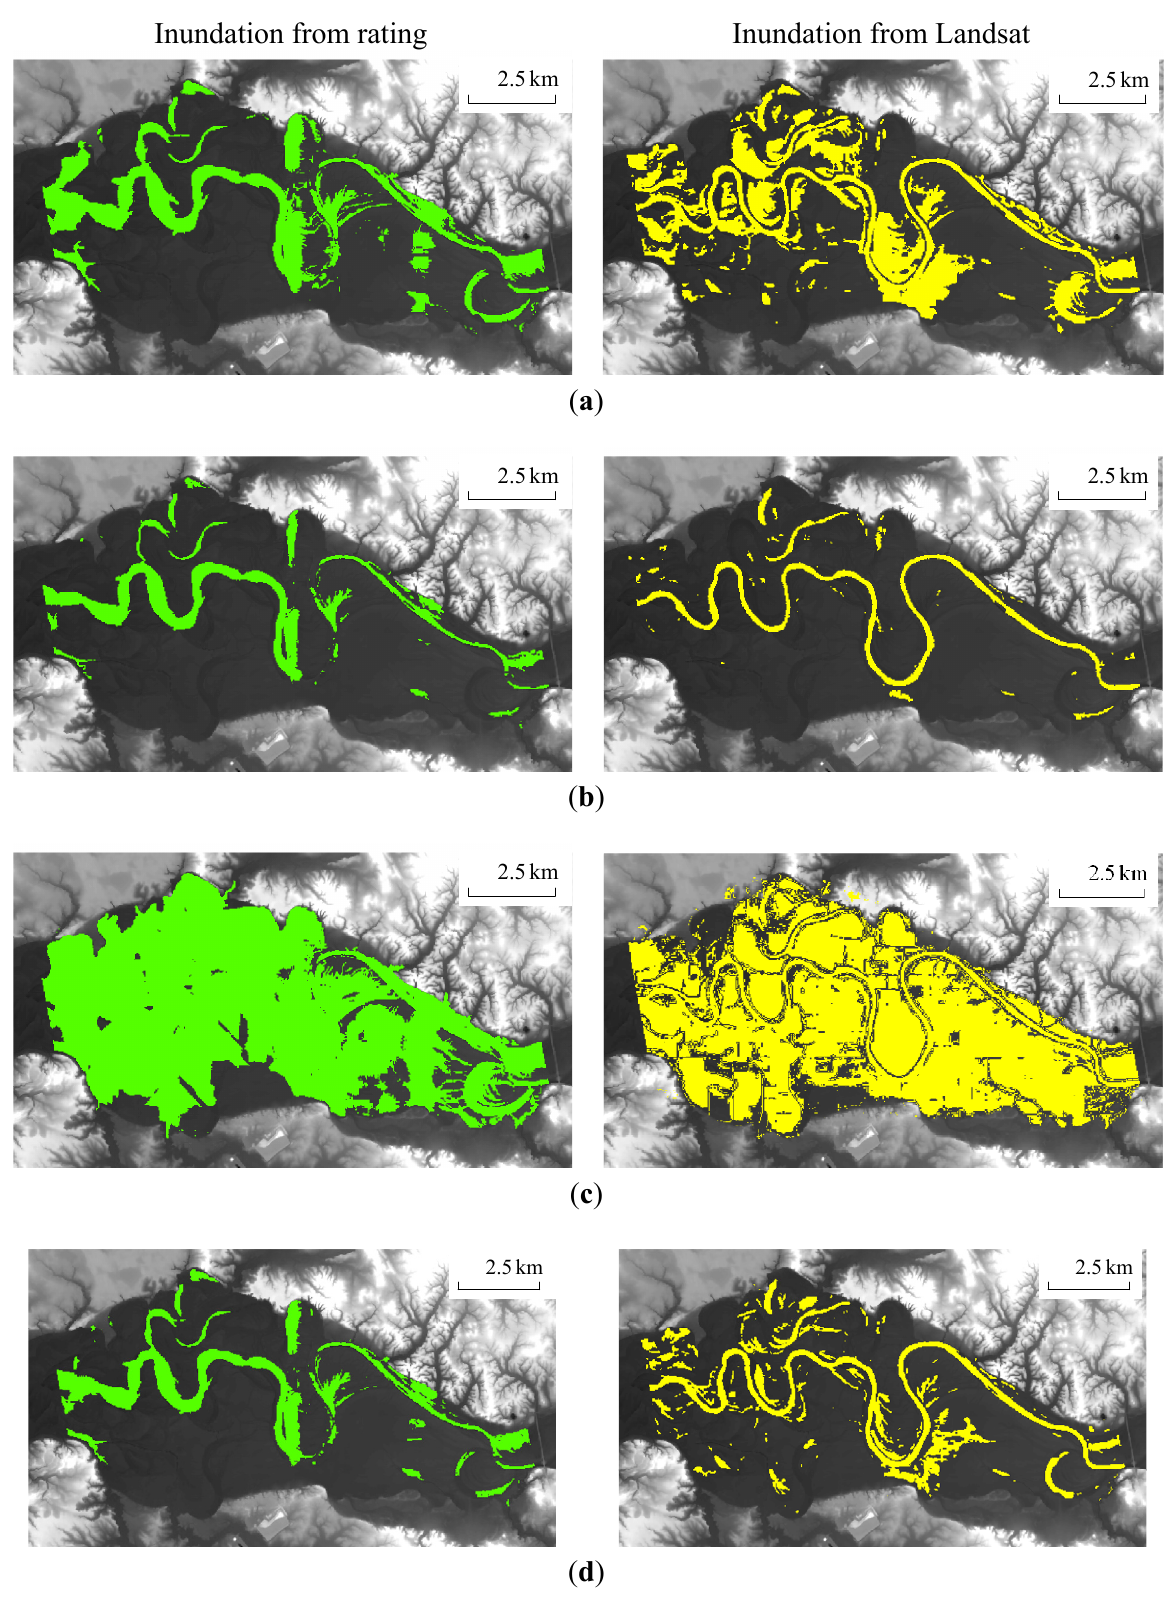
Figure 9. Comparison of inundations from rating equations and from Landsat images for the Petersburg reach. ( a ) Flood flow of 1260 m 3 /s on 5 March 2007; ( b ) Flood flow of 517 m 3 /s on 22 April 2007; ( c ) Flood flow of 3645 m 3 /s on 11 June 2008; Flood flow of 808 m 3 /s on 3 July